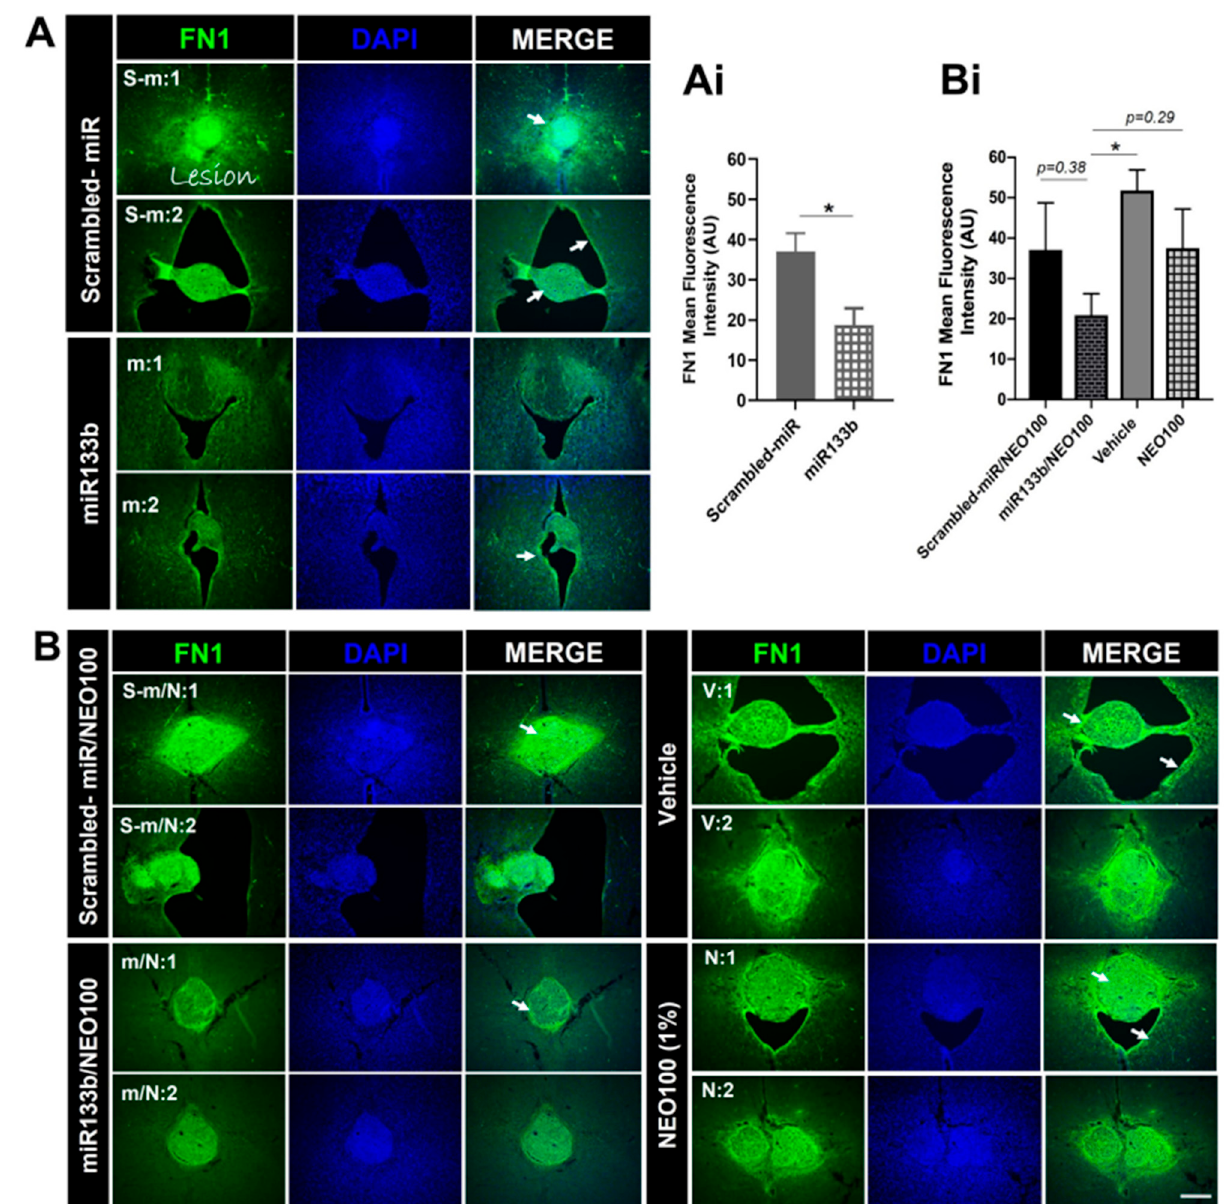
Figure 7. The e ff ect of intranasal delivery of miR133b/Ago2 either alone or in combination with 1% NEO100 on the fi bronectin (FN1) protein expression at the lesion scar at 56 days post-injury. Panels ( A − B ) show representative images of the spinal cord sections immunolabeled with FN1. Sections were collected from two di ff erent mice per group, as follows: s-m:1 and s-m:2 from scrambled − miR group; m:1 and m:2 from miR133b/Ago2 group; s − m/N:1 and s − m/N:2 from scrambled − miR/NEO100; m/N:1 and m/N:2 from miR133b/Ago2/NEO100 group; v:1 and v:2 from vehicle and N:1 and N:2 from NEO100 group. Panels ( Ai , Bi ) represent the fl uorescence quanti fi cation of FN1. T-test was employed for comparing the groups in graph ( Ai ). One − way ANOVA with Dunne tt ’s mul- tiple comparison test was used for comparing the groups in graph ( Bi ). * p < 0.05; n = 4–5 sections per mouse, n = 3–5 mice per group. Note: The arrows indicate the FN1 expression at the lesion scar. Scale bar: 100 µm.